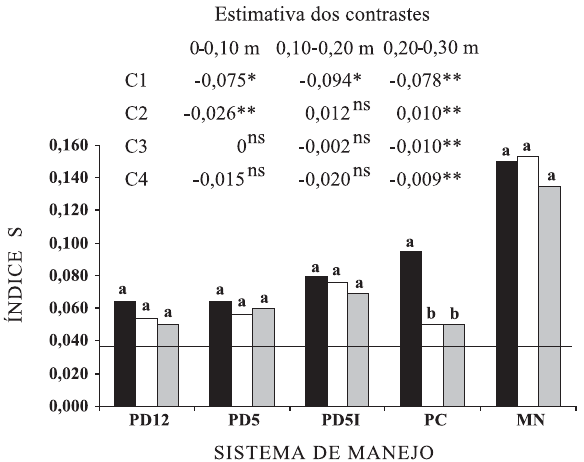
Figura 2. Valores de Índice S e estimativa dos contrastes estabelecidos para os cinco tratamentos e três profundidades. Camada de 0–0,10m